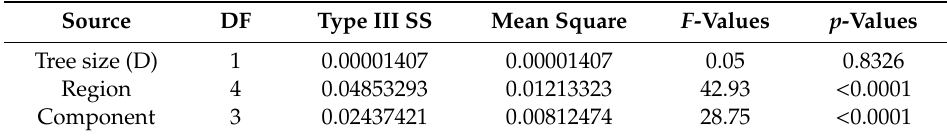
Table 3. The e ff ects of tree size (D), region, and tree component on carbon concentrations of Mongolian oak. Degrees of freedom (DF) and type III sum of squares (SS) are